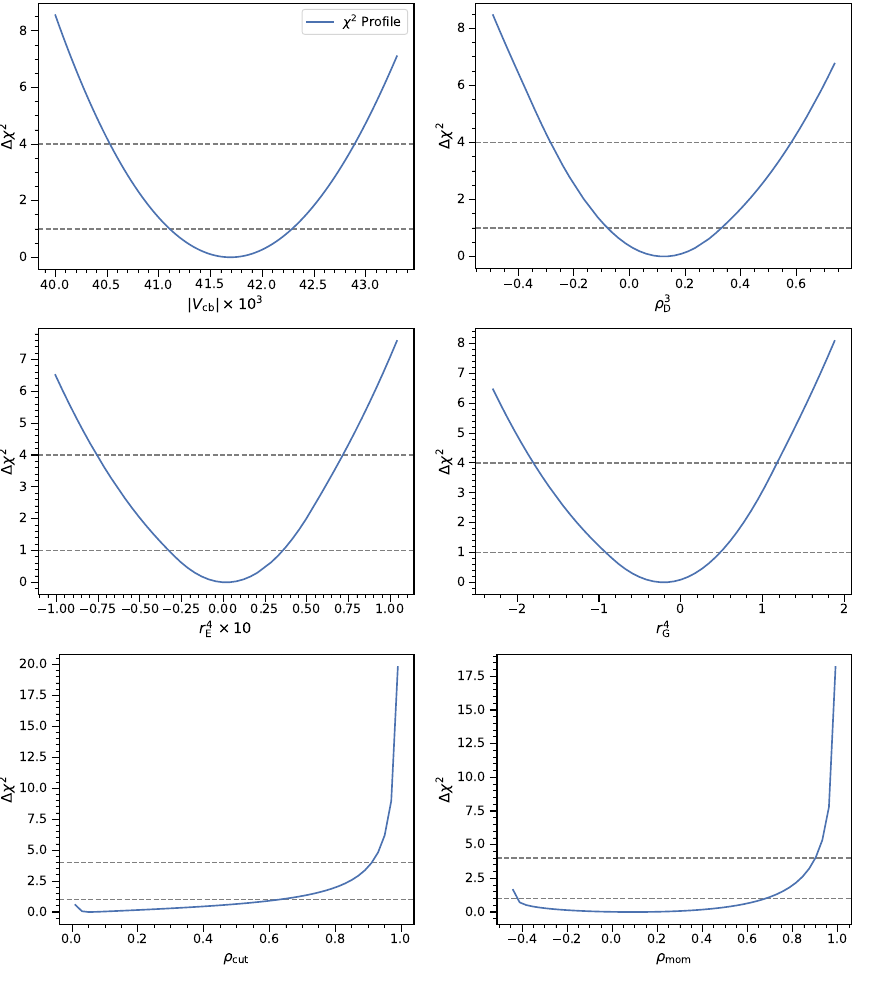
, r 4 . The minimum χ 2 × 10 , and r 4 D E G